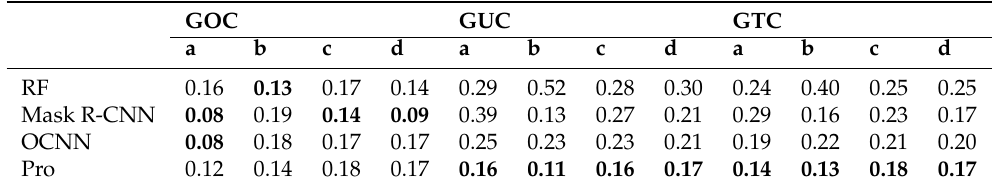
Table 2. Geometric accuracies of the RF, Mask R-CNN, OCNN, and the proposed method (labeled as Pro) classifications for the four test areas, evaluated by global over-classification (GOC), global under-classification (GUC), and global total classification (GTC) error indices.